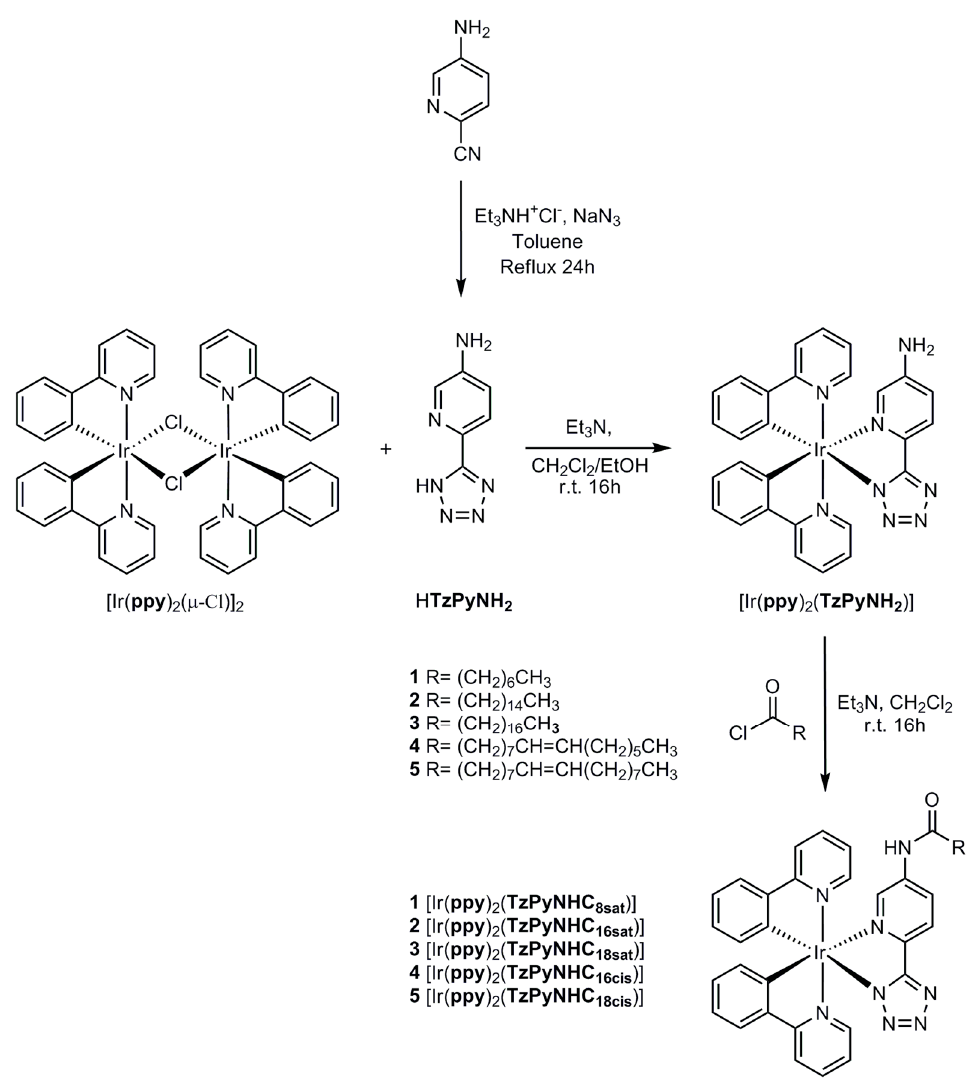
Figure 1. Summary of the synthetic procedures for the preparation of the H TzPyNH 2 ligand and the fatty acid functionalised Ir complexes.